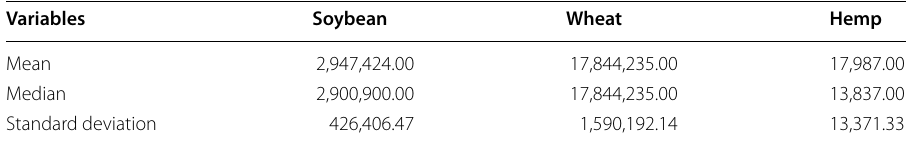
Table 1 Descriptive statistics of soybean, wheat, and hemp acreage in Canada, 1998–2011. Source : Alberta Agriculture and Rural Development (2012) and Statistics Canada